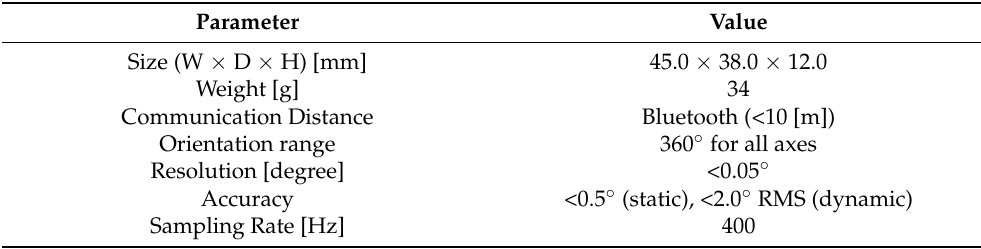
Table 2. Specification of WB-4 IMU used in the experiment.